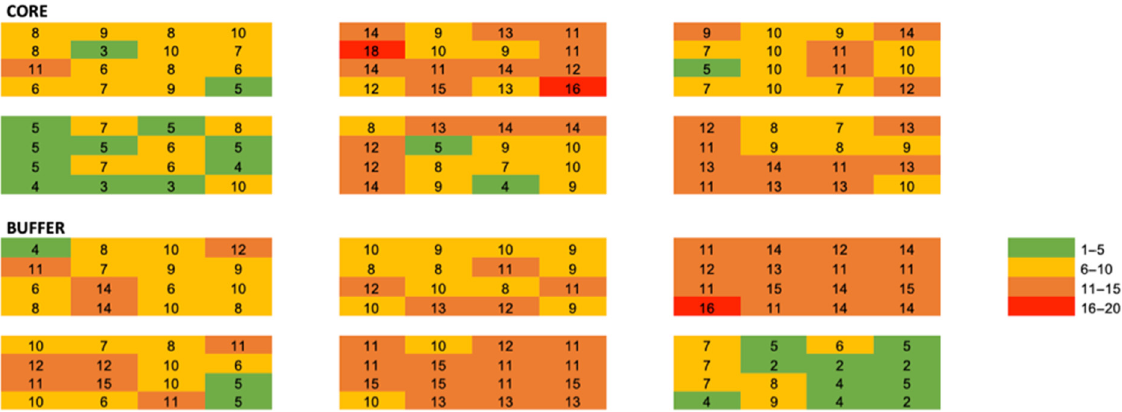
Figure 4. Heat map of genus richness among all quadrats and plots. Values are absolute richness per quadrat.